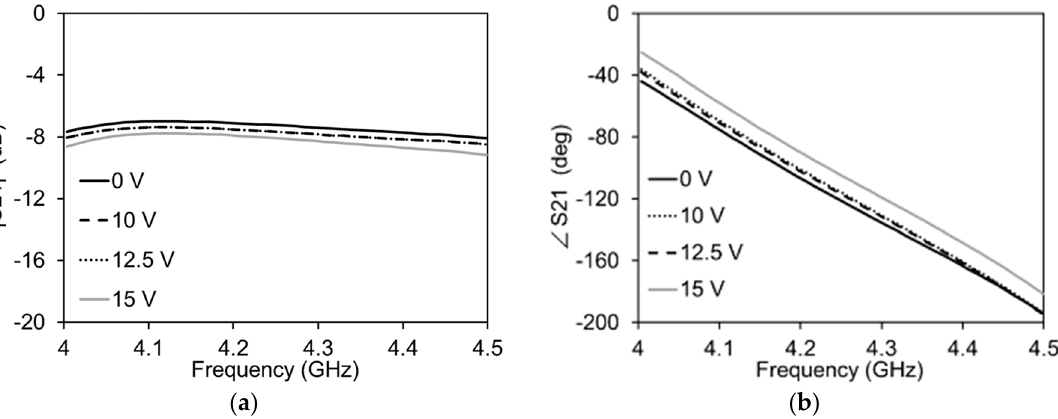
( a ) Amplitude variation; ( b ) Phase variation.